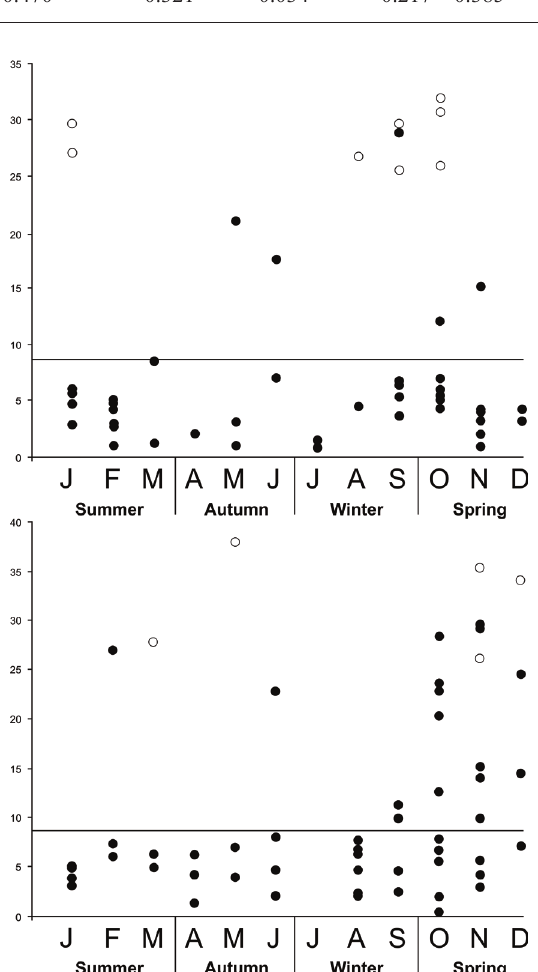
Figure 3 - Monthly variation in diameter (mm) of the largest follicles (black circles) and eggs (white circles) of Philodryas aestiva (upper image) and Philodryas patagoniensis (bottom image) from the Brazilian coastal Pampa, Rio grande do Sul state. The horizontal line represents the length of the largest axis from which the follicles are considered in secondary vitellogenesis (9